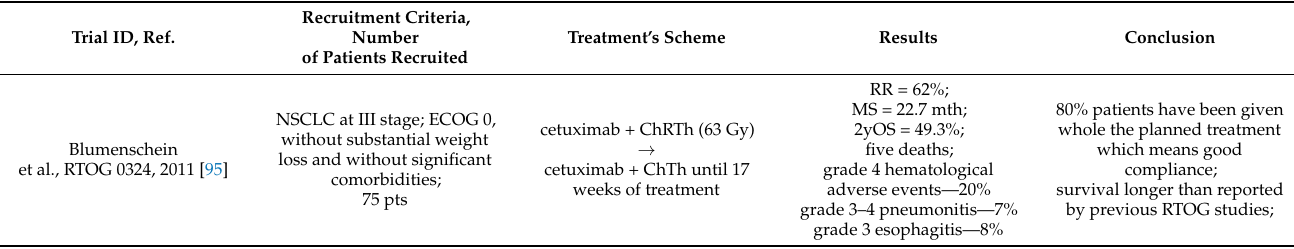
Table 4. Targeted therapies combined with radiochemotherapy in the radical treatment intensification attempts—results of the